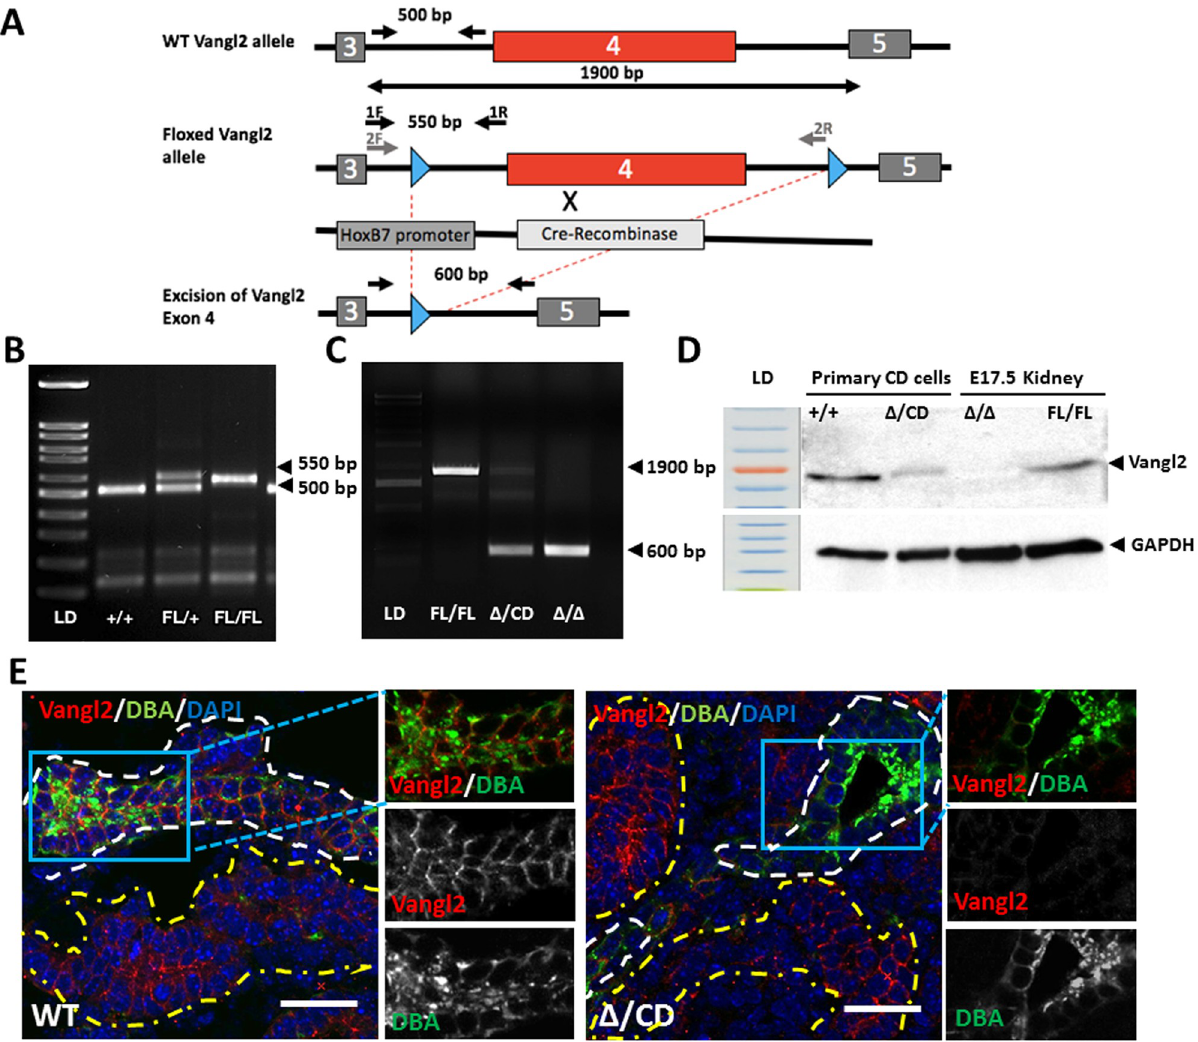
Fig 2. Generation of Vangl2 knockout mouse with excision of Exon 4. (A) Strategy to excise Vangl2 gene in collecting duct cells using Cre- Recombinase under the HoxB7 promoter. (B) Images of tail DNA amplicons: 500 bp wildtype and 550 bp Floxed Vangl2 allele. (C) Excision of Vangl2 ( Δ Exon 4) generates a 600 bp amplification fragment, the Floxed allele is amplified as a 1900 bp fragment; Fl/Fl and Δ / Δ lanes- tail DNA amplification, Δ /CD lane—amplification of DNA from medullary zone of P1 kidneys. (D) Western immunoblot with anti-Vangl2 and anti-GAPDH antibodies: protein lysates from primary collecting duct cells isolated from P5 Cre+;Vangl2 +/+ and Vangl2 Δ /CD mice as well as protein lysates from E17.5 kidneys of Cre-;Vangl2 Fl/Fl and Vangl2 Δ / Δ were used. (E) Immunofluorescent staining with anti-Vangl2 antibody (red), DBA (collecting duct marker, green) and DAPI (blue). DBA(+) tubules are contoured in white, DBA(-) tubules—in yellow. Scale bars, 50 μ